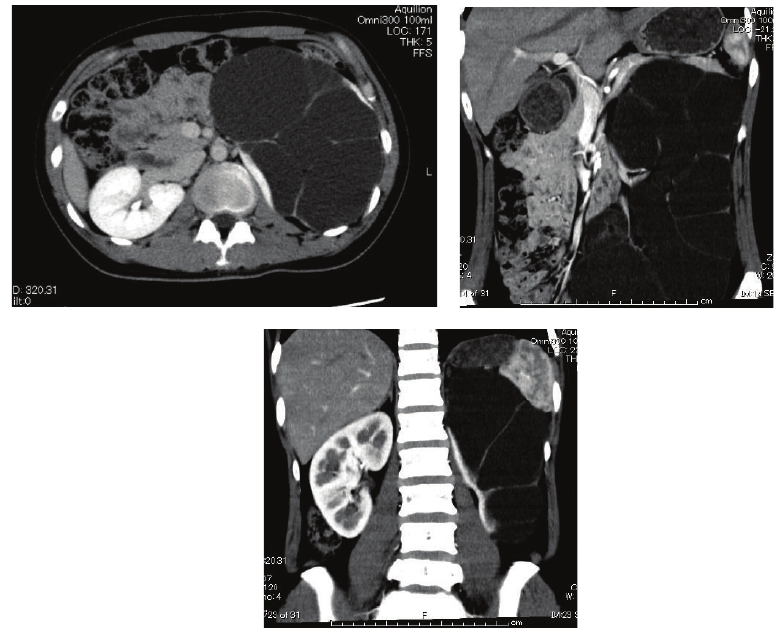
Figure 1: Computed tomography shows dilated left urinary tract and thin renal parenchyma.